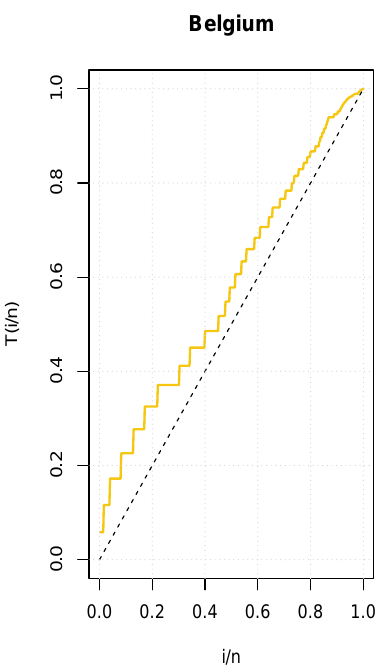
Figure 7. Total Time on Test (TTT) plot for the COVID-19 data set of